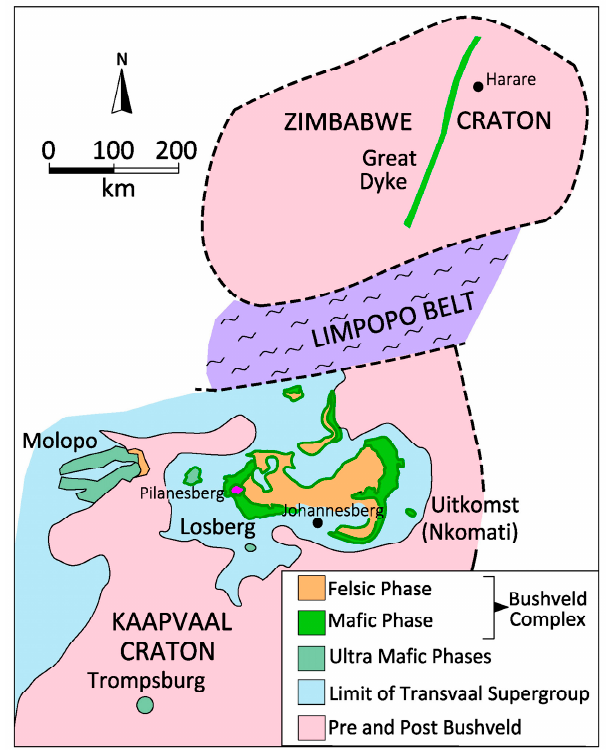
Figure 1. Location of the Bushveld Complex and the Great Dyke in southern Africa (Reproduced with permission from M. Viljoen, Episodes [10]).